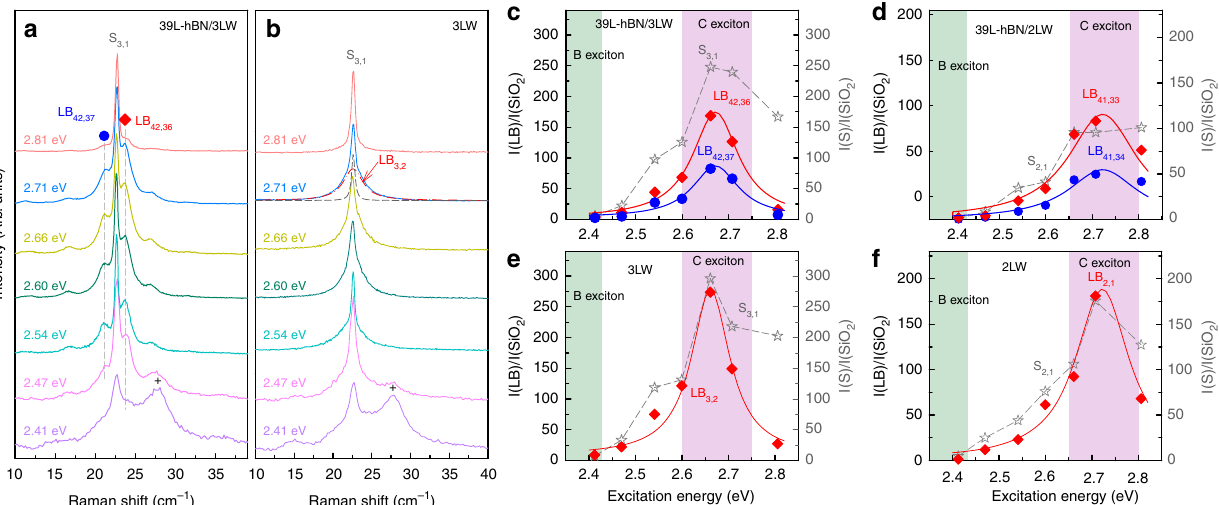
Fig. 3 Intensity resonances of the S and LB modes in 39L-hBN/ m LW and corresponding m LW. Raman spectra of a 39L-hBN/3LW and b 3LW excited by E ex in the range of 2.41 – 2.81 eV. The diamonds and circles represent the two prime LB modes in 39L-hBN/3LW. The crosses show TA phonons resonant with the B exciton 45 . The resonant pro fi les of c the LB 42,36 (red diamonds), LB 42,37 (blue circles) and S 3,1 (gray stars) in 39L-hBN/3LW, d the LB 41,33 (red diamonds), LB 41,34 (blue circles) and S 2,1 (gray stars) modes in 39L-hBN/2LW, e the S 3,1 (gray stars) and LB 3,2 (red diamonds) modes in 3LW fl ake, f the S 2,1 (gray stars) and LB 2,1 (red diamonds) modes in 2LW fl ake. The diamonds, circles, and stars represent the experimental data while the red and blue solid lines are the fi tting results. The Raman intensity is normalized by the E 1 mode of quartz at ~127 cm − 1 to eliminate the different ef fi ciencies of charge- coupled device at different E